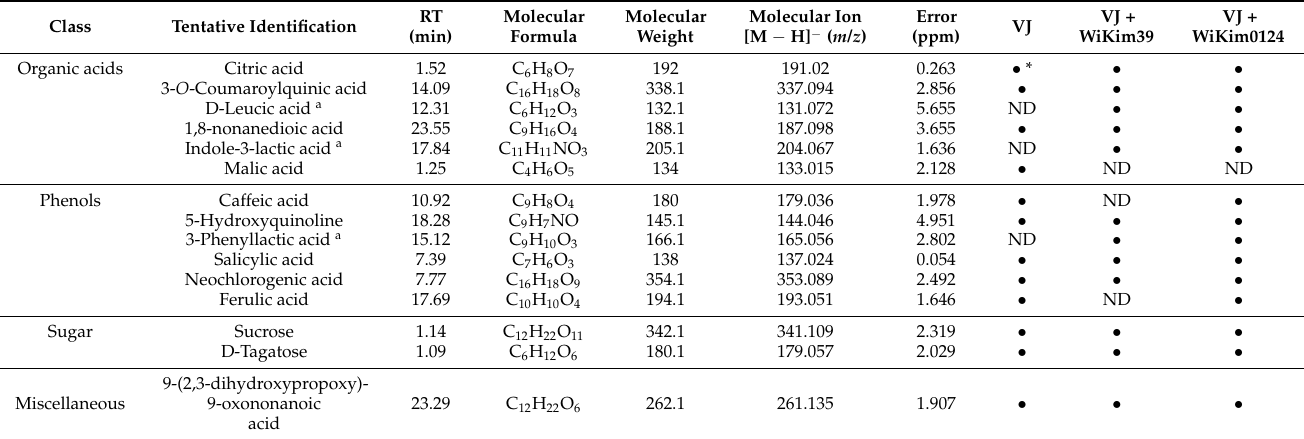
* Filled circles indicate presence of metabolites. a The compound was further identified using the corresponding standard compound ND, not